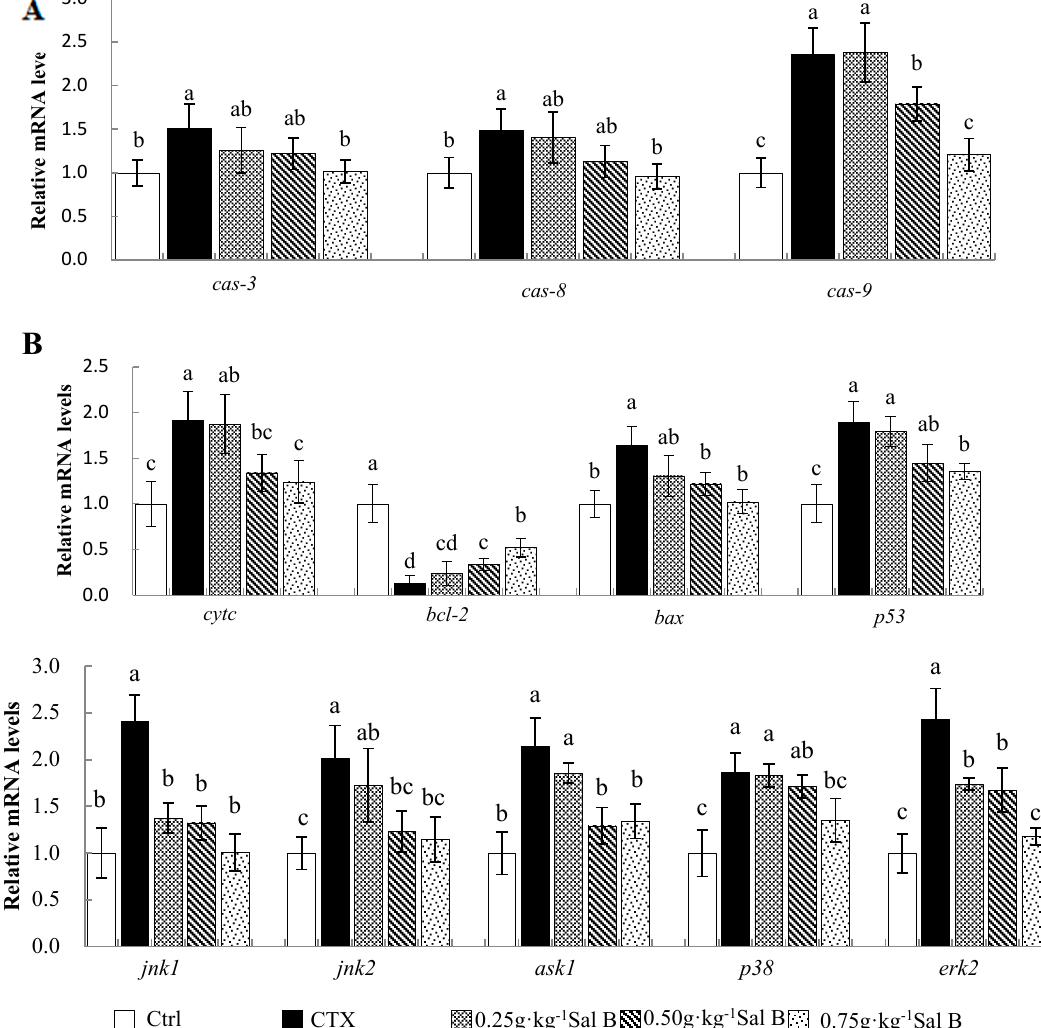
Figure 5. Effects of Sal B on apoptosis and MAPK-pathway-related genes mRNA levels in liver of Nile tilapia. ( A , B ), expression of apoptosis-related genes; ( C ), expression of MAPK-pathway-related genes. The values are means ± SE ( n = 8). a,b,c Different superscript letters for each parameter indicate significant differences ( p < 0.05).